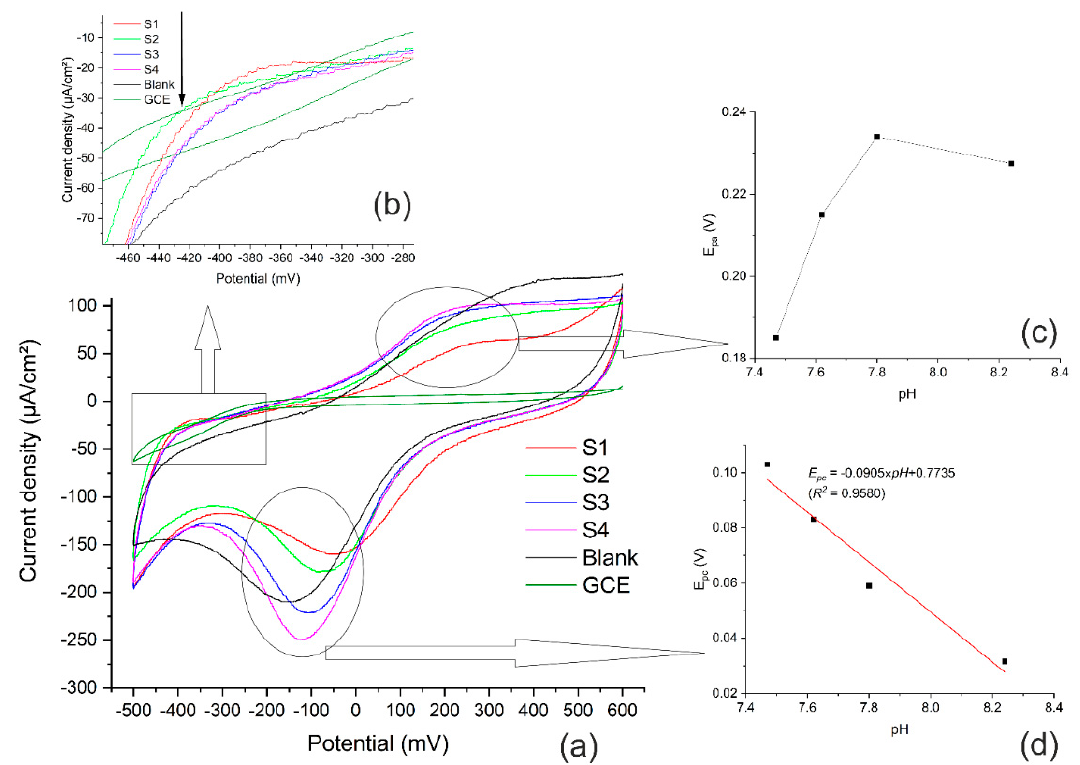
Figure 2. Cyclic voltammetry of the Pd/MWCNT composite in different concentrations of deuterated water ( a ): in the inset ( b ) it is shown the increase in the capacitance of the electric double layer; ( c ) shows the effect of the pH of the solution on the anodic and cathodic current ( d ) .